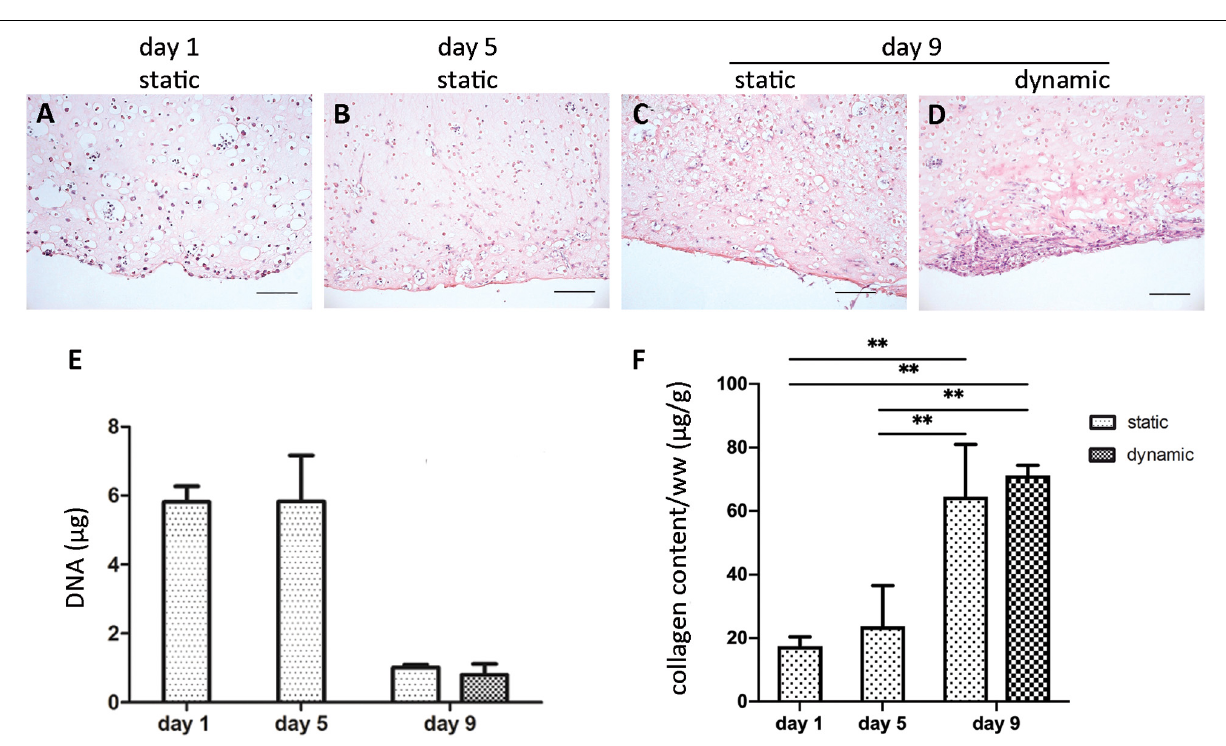
units ( Figures 4G,H ). Such features were not detected in